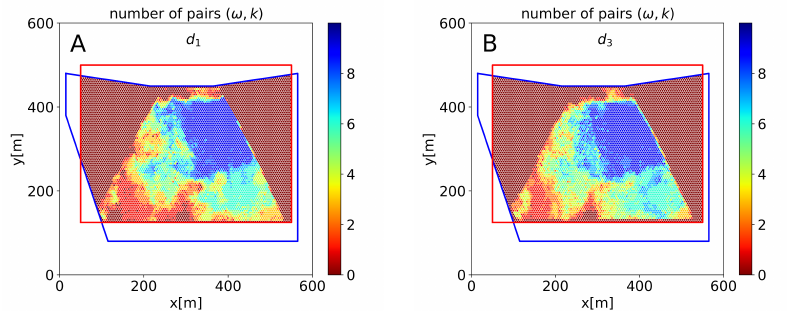
Figure 11. Number of useful pairs ( ω , k ) obtained for the planview video for d 1 ( A ) and d 3 ( B ).